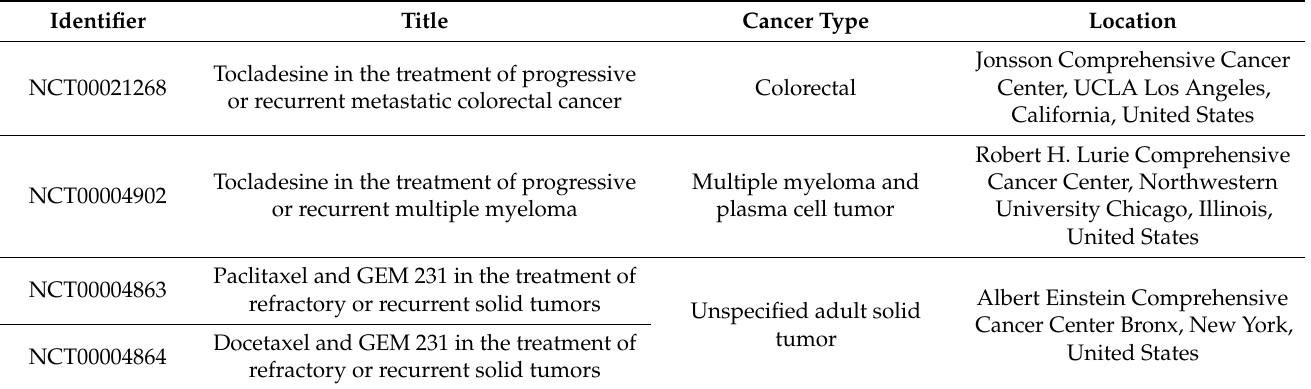
Table 2. Clinical trials on the cAMP–PKA pathway-targeting anticancer medicines (from clinicaltrials. gov (accessed on 15 June